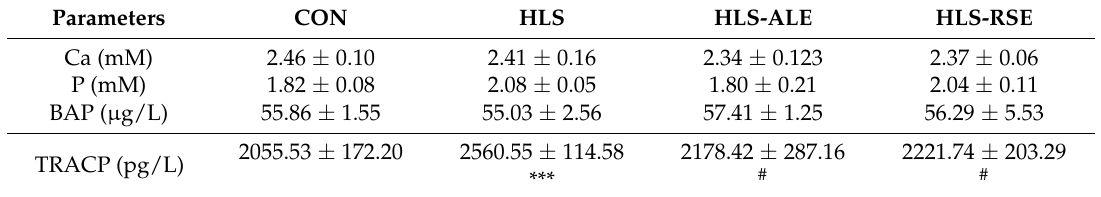
Table 2. Bone turnover markers in rat serum within various treatment groups ( n =